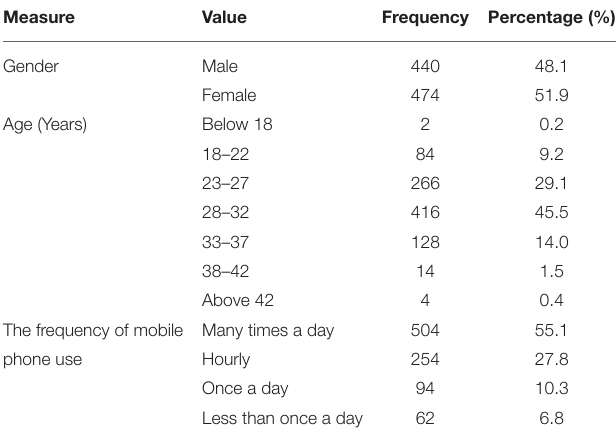
TABLE 1 | Descriptive statistics of respondent